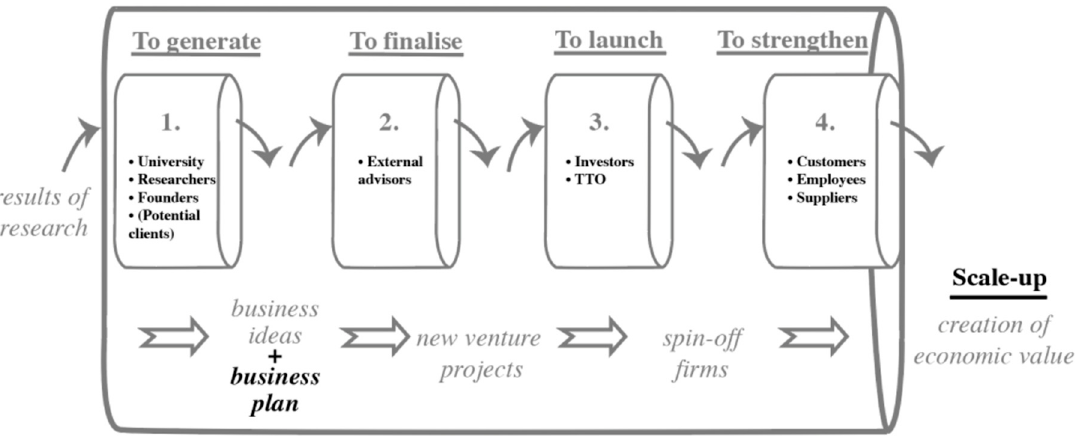
Figure 7. Global process of valorization by spin-off, adapted from Ndonzuau et al. (2002) and enriched with the answers of the USO respondents.